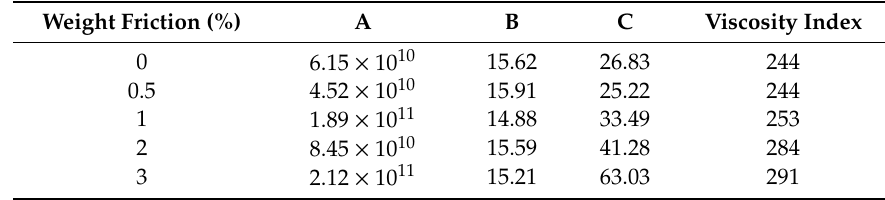
Table 2. The coe ffi cients and viscosity Table 2. The coefficients and viscosity index.